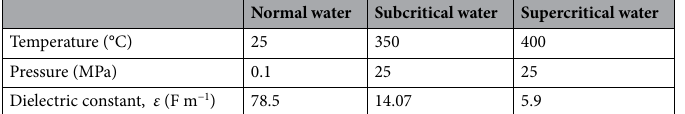
Table 1. Variation of the dielectric constant of water with temperature and pressure 9